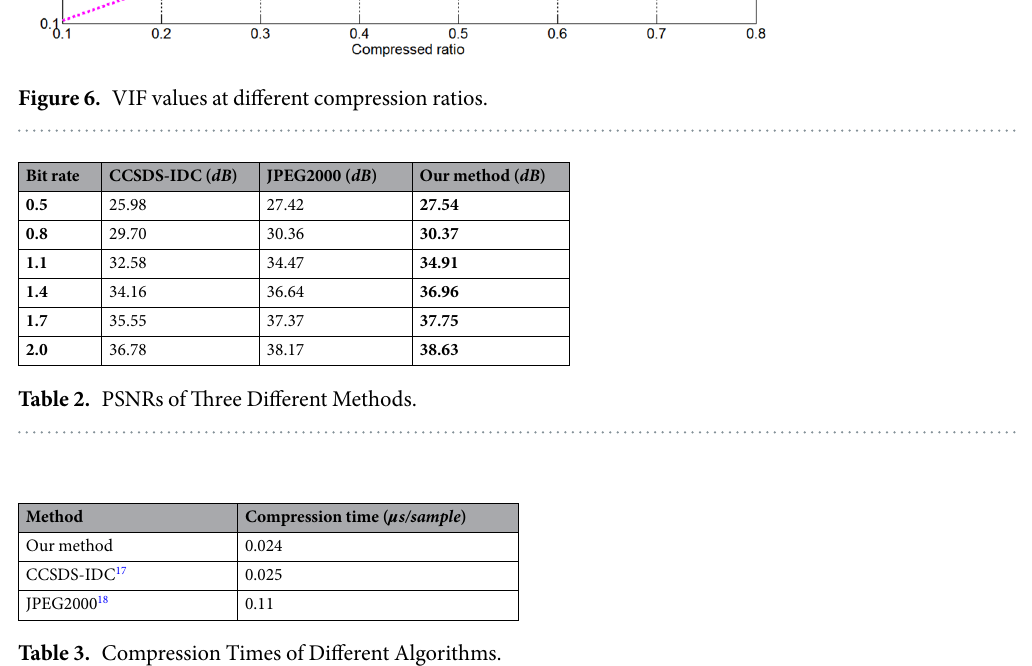
Table 3. Compression Times of Different